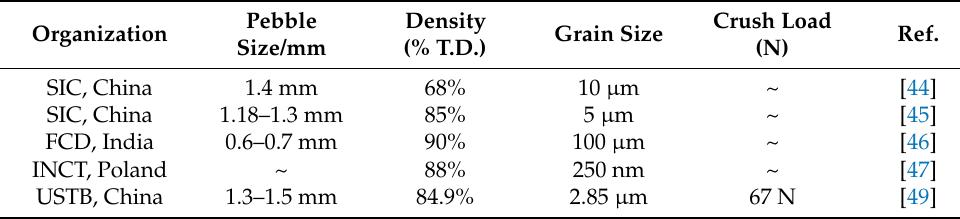
Table 3. Recent developments in the fabrication of Li 2 TiO 3 by the sol–gel method.